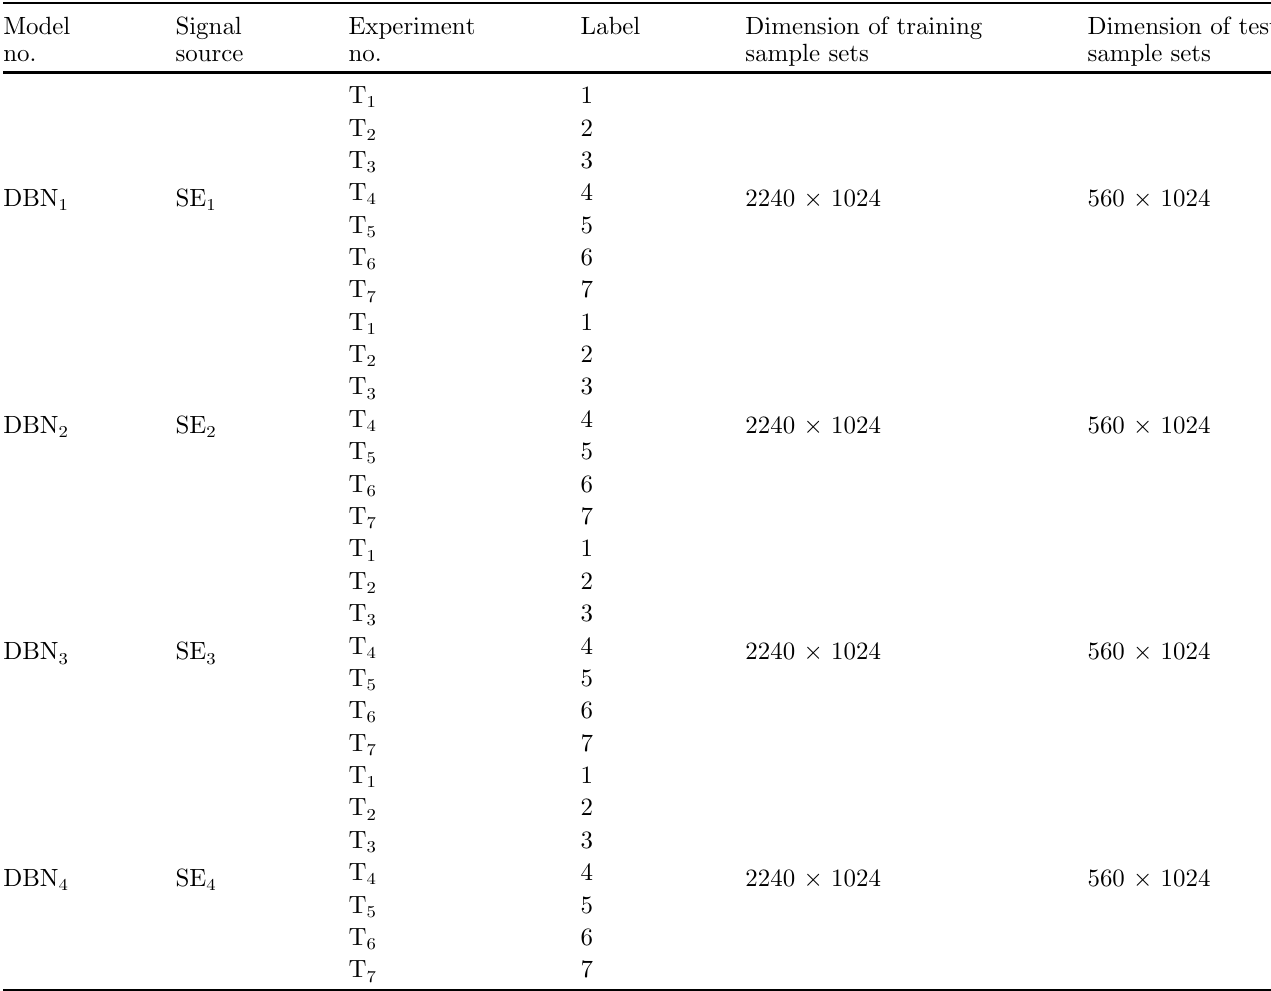
Table 2. The Sample Sets for DBNs.